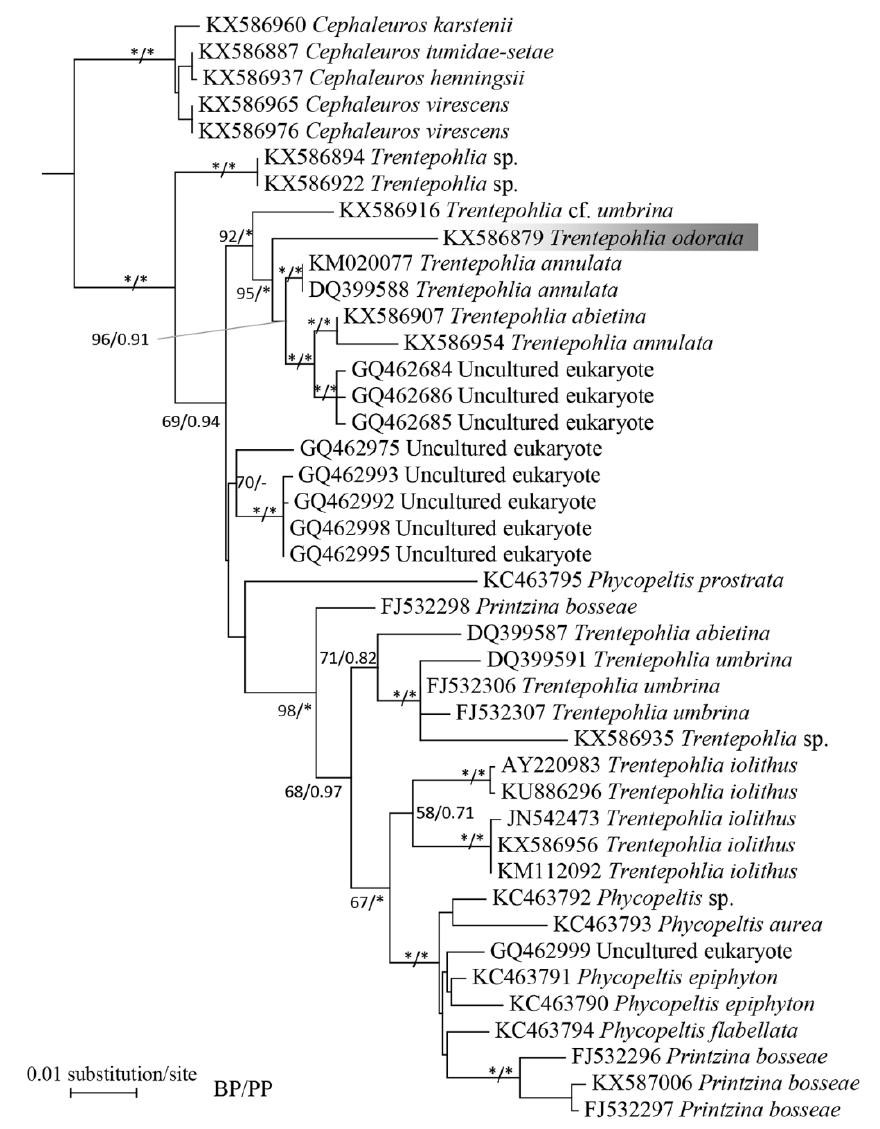
Figure 2. The maximum likelihood phylogram inferred from 18S rDNA sequences of Trentepohliales. The monophyletic genus Cephaleuros was used as outgroup. Maximum likelihood bootstrap values (1000 replicates) and Bayesian posterior probabilities (PPs) are given near the nodes, and only bootstrap proportion (BP) and PP values above 50 and 0.50 are shown. The full statistical support (100/1.00) is marked with an asterisk. The Trentepohlia odorata was shaded in grey.